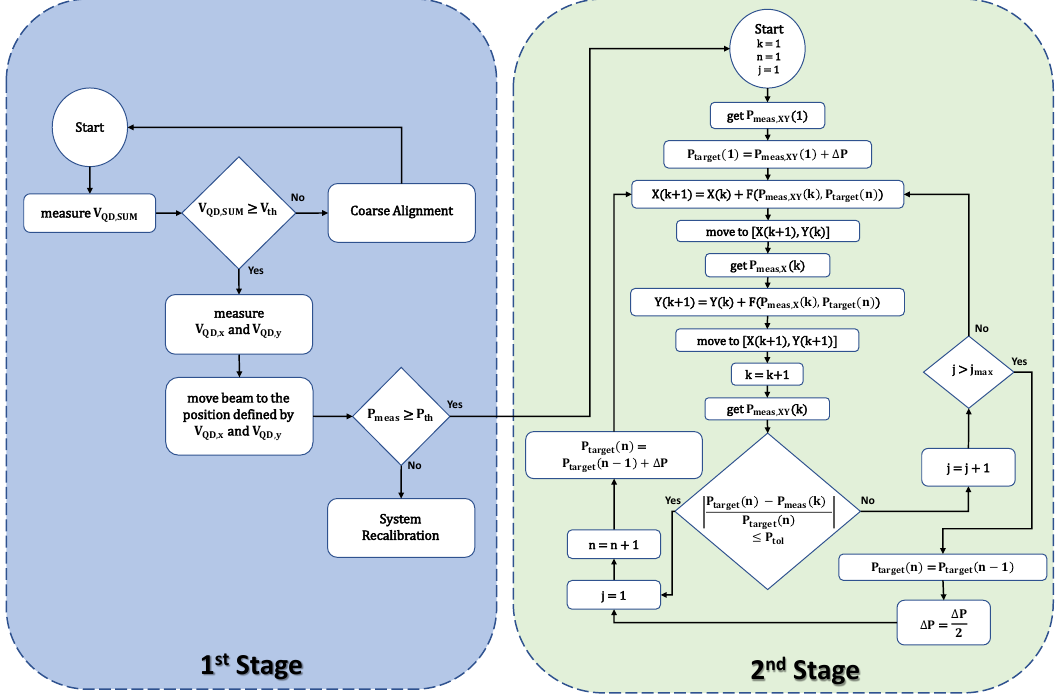
Figure 8. Proposed two-stage bidirectional algorithm architecture. 2nd Stage: This stage is referred to as the optical-power-based stage. It starts by mea- suring the initial optical power that is collimated into the Rx fiber, P meas, XY ( 1 ) . Afterwards, a power target is defined by incrementing ∆ P = 0.5 dB to the previously measured power ( P target (1) = P meas, XY ( 1 ) + ∆ P ), and the optimization algorithm is employed to reach that threshold by setting different absolute positions ( X ( k ) and Y ( k ) ). After j iterations, the target is expected to be reached, i.e., the error should vanish. Otherwise, the algorithm has = 10, where the set target has exceeded the entered a saturation zone, j > j max